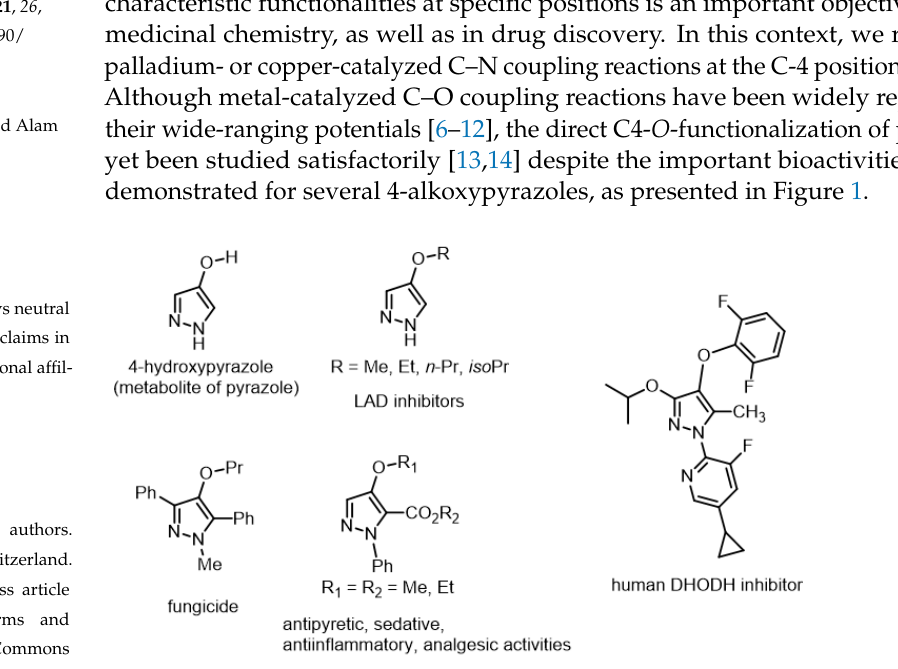
Figure 1. Bioactive 4-alkoxypyrazoles.